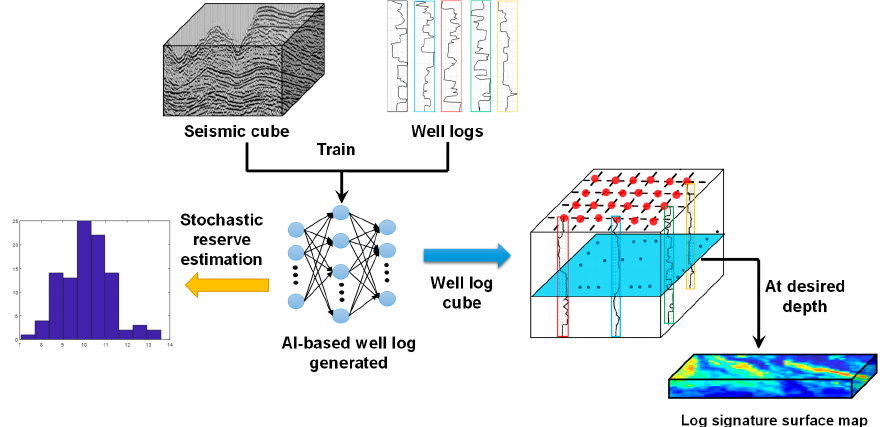
Figure 6. Workflow of intelligence system: Stage-I. Energies 2018 , 11 , x